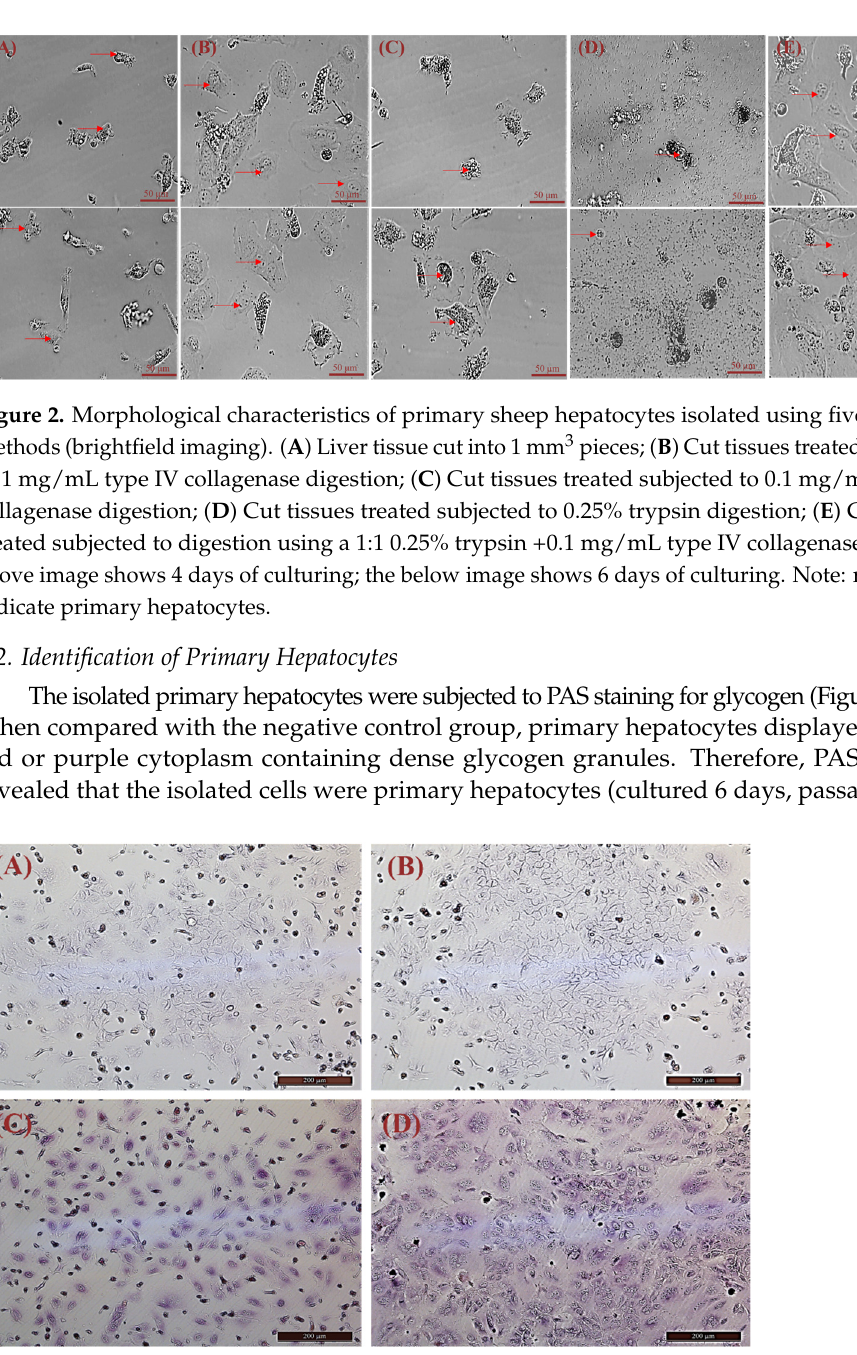
Figure 1. Morphological characteristics of isolated primary sheep hepatocytes ( brightfield imaging). ( A ) Hepatocytes adhered to the surface after 2 days. ( B ) At low density, hepatocytes acquire an irregular polygon shape after 4 days. Note: red arrows indicate primary hepatocytes .